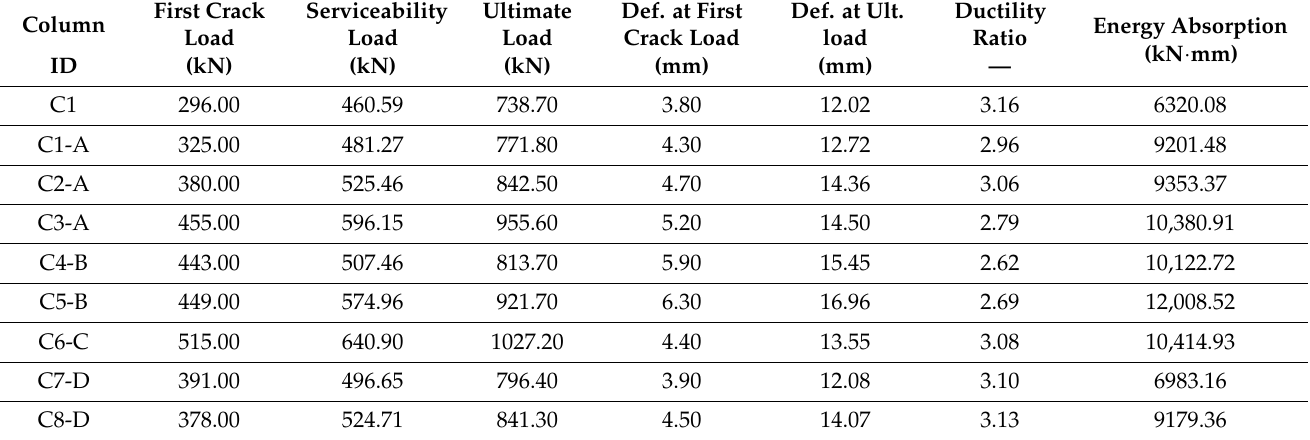
Table 7. Experimental test